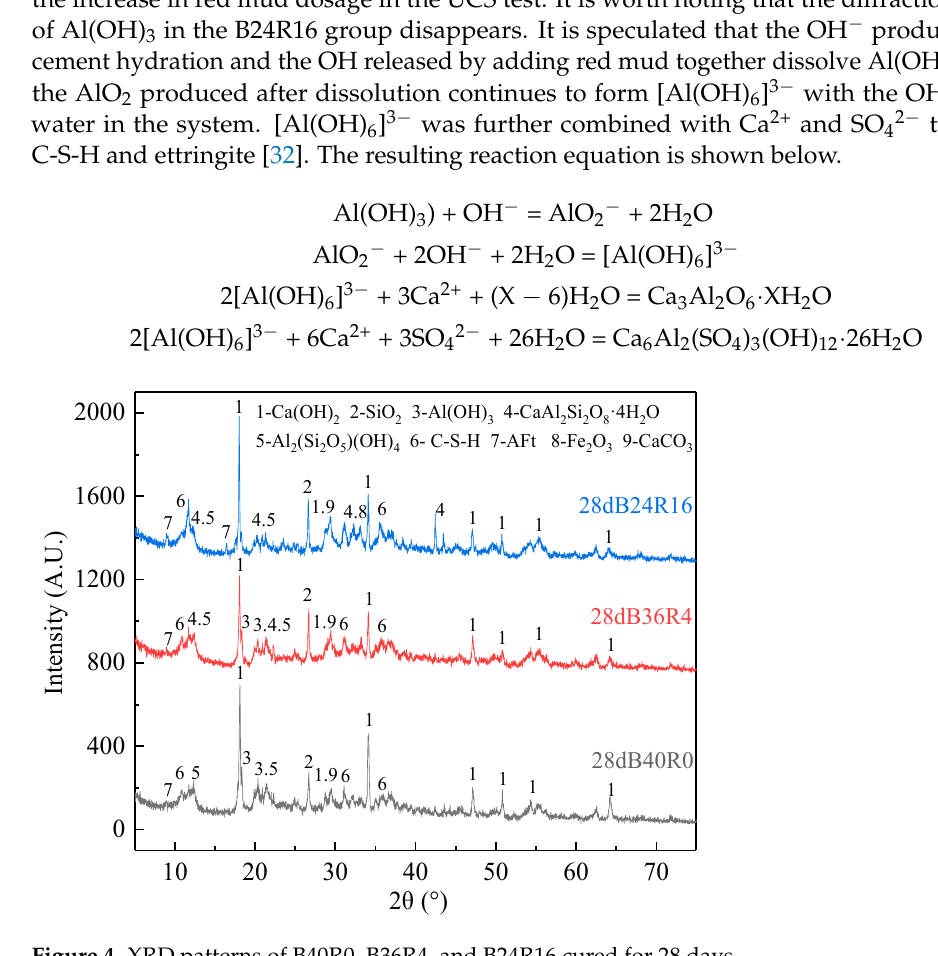
Figure 4. XRD patterns of B40R0, B36R4, and B24R16 cured for 28 days.